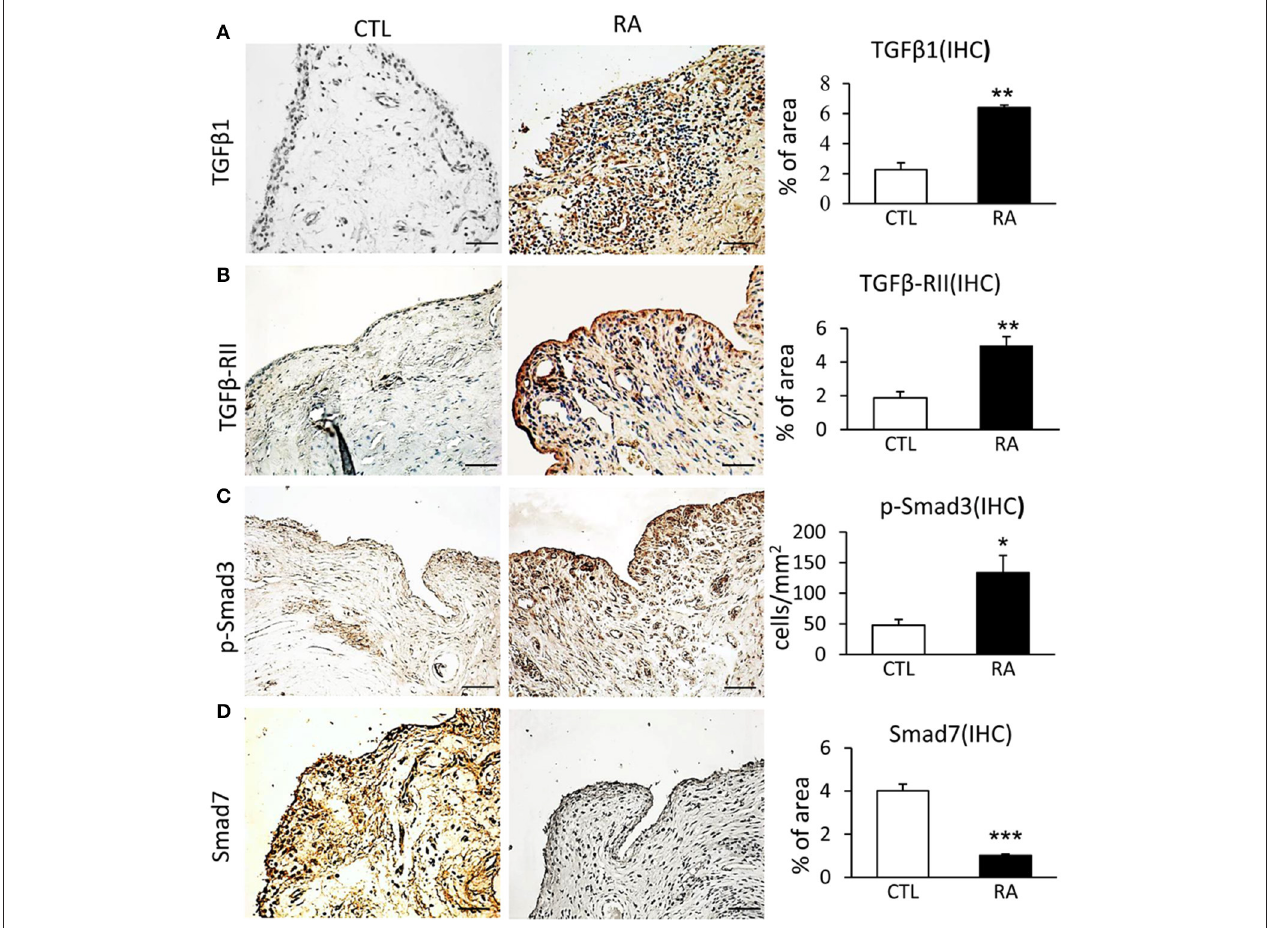
FIGURE 1 | Immunohistochemistry shows an imbalance of TGF- β /Smad signaling with overaction of Smad3 but loss of Smad7 in the synovial tissues of RA patients. (A) Expression of TGF- β 1. (B) Expression of TGF- β receptor II. (C) Activation of Smad3 signaling identified by phospho-Smad3 nuclear location. (D) Expression of Smad7. Data represent mean ± S.E. for 14 RA patients. * p < 0.05, ** p < 0.01, *** p < 0.001 compared to normal controls. Scale bar, 50 µ